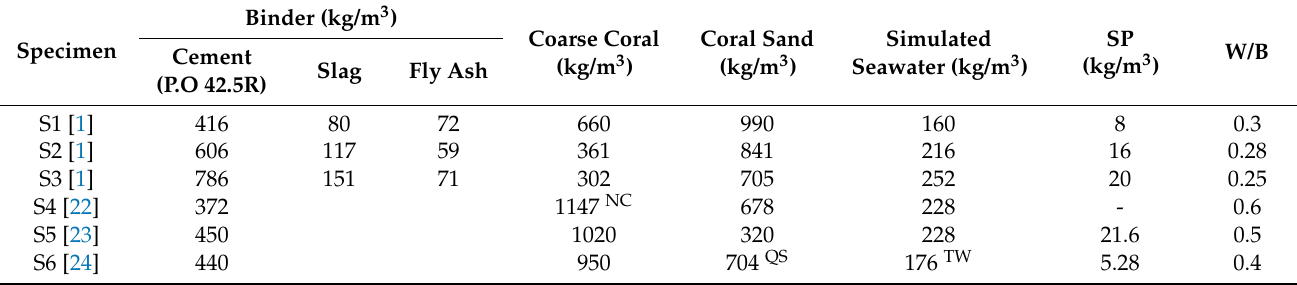
Figure 1. Compressive strength of marine concrete (30 MPa) [7,13–21] and enhanced marine concrete (40–50 MPa) [1,22–24]. Table 1. Material contents of specimens shown in Figure